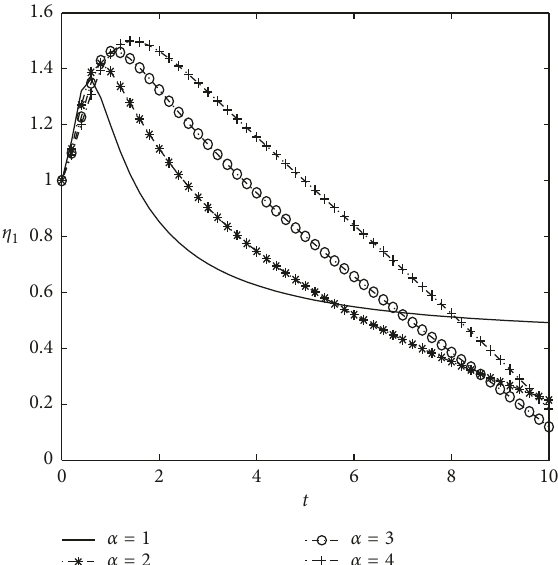
Figure 15: η over time for various values of α when applying the fourth nonlinear adaptive controller. 1